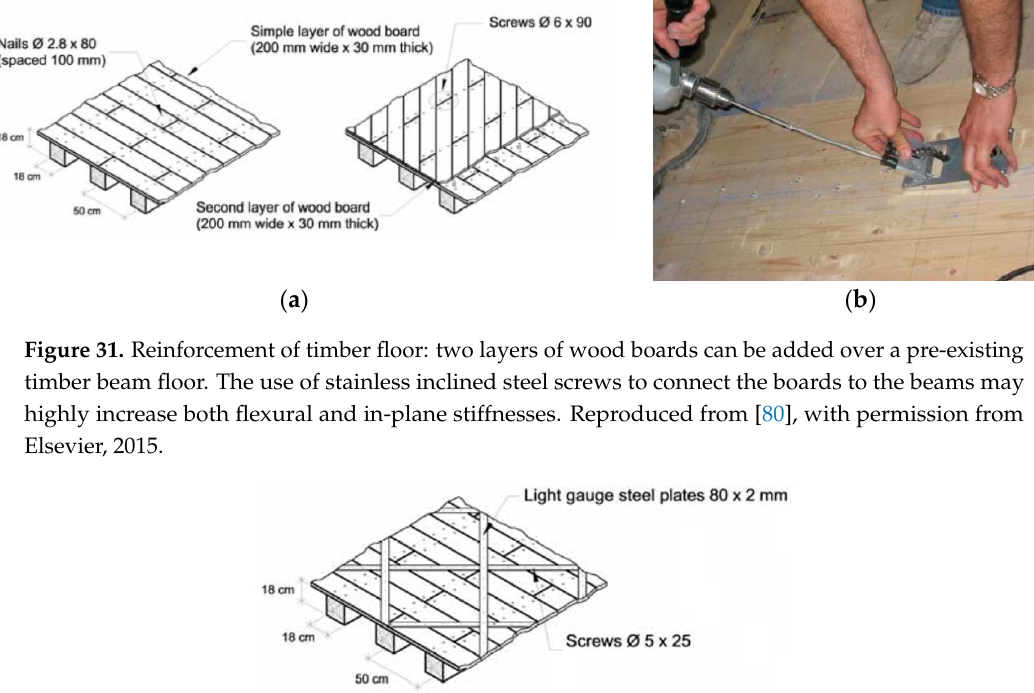
Figure 32. A possible alternative solution to the use of a double layer of timber boards—application of stainless steel strips over the new or pre-existing wooden floor boards. Reproduced from [80], with permission from Elsevier, 2015.